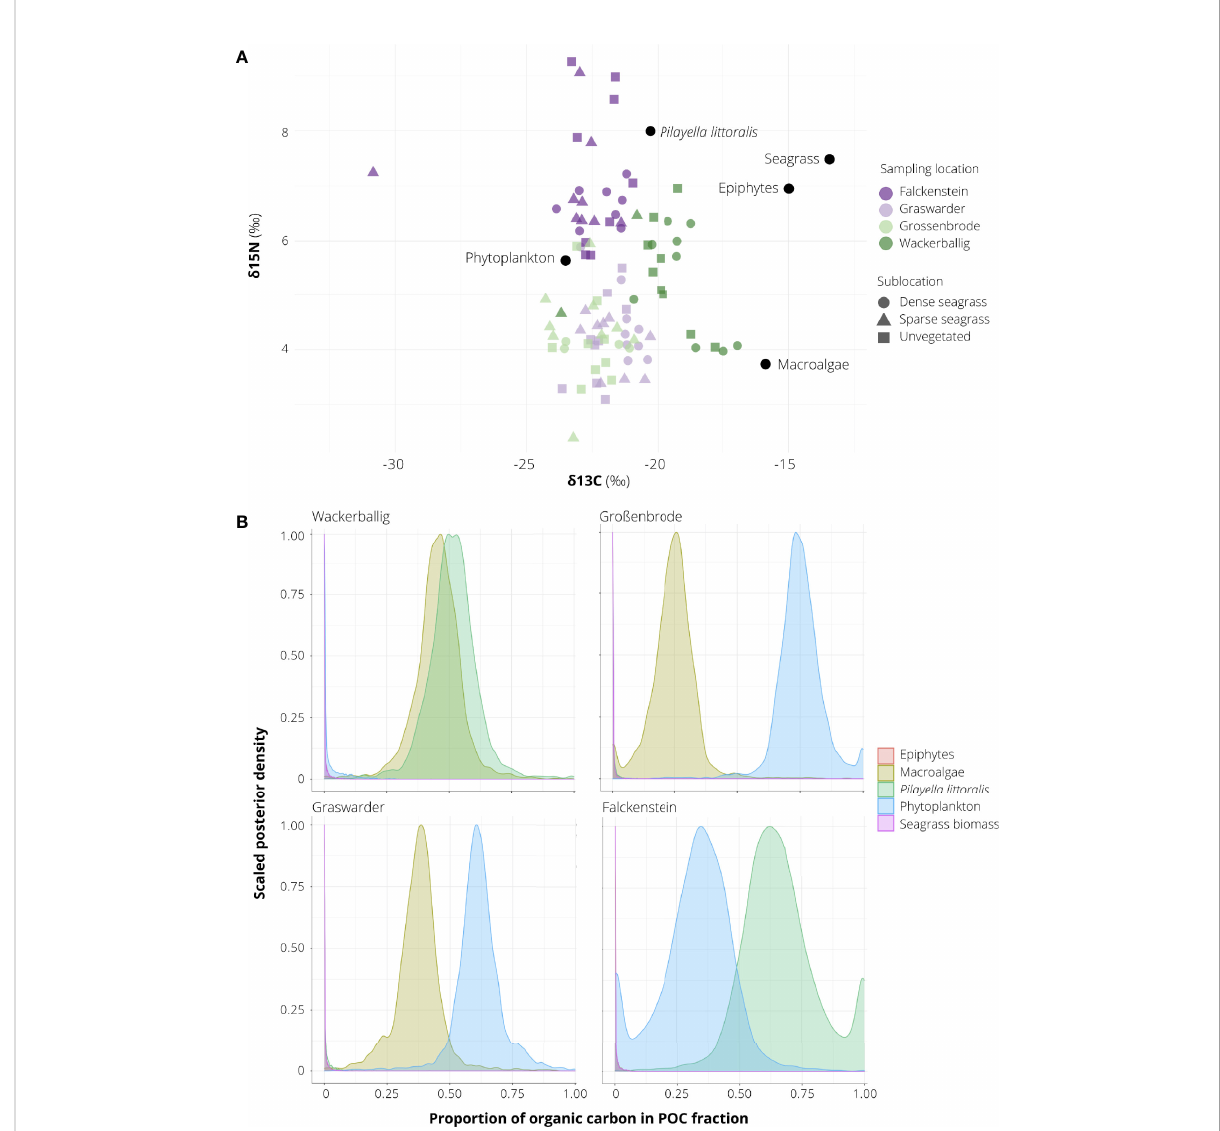
FIGURE 4 d 13 C and d 15 N stable isotope signatures (A) and posterior estimates of the proportion of organic carbon (C in seagrass-vegetated and unvegetated sublocations off the coasts of Falckenstein (FS), Wackerballig (WB), Grossenbrode (GB), Graswarder and (GW) in northern Germany. Sources (black circles) were obtained from Table 1 in Mittermayr et al. (2014) and Table 2 in Maksymowska et al.